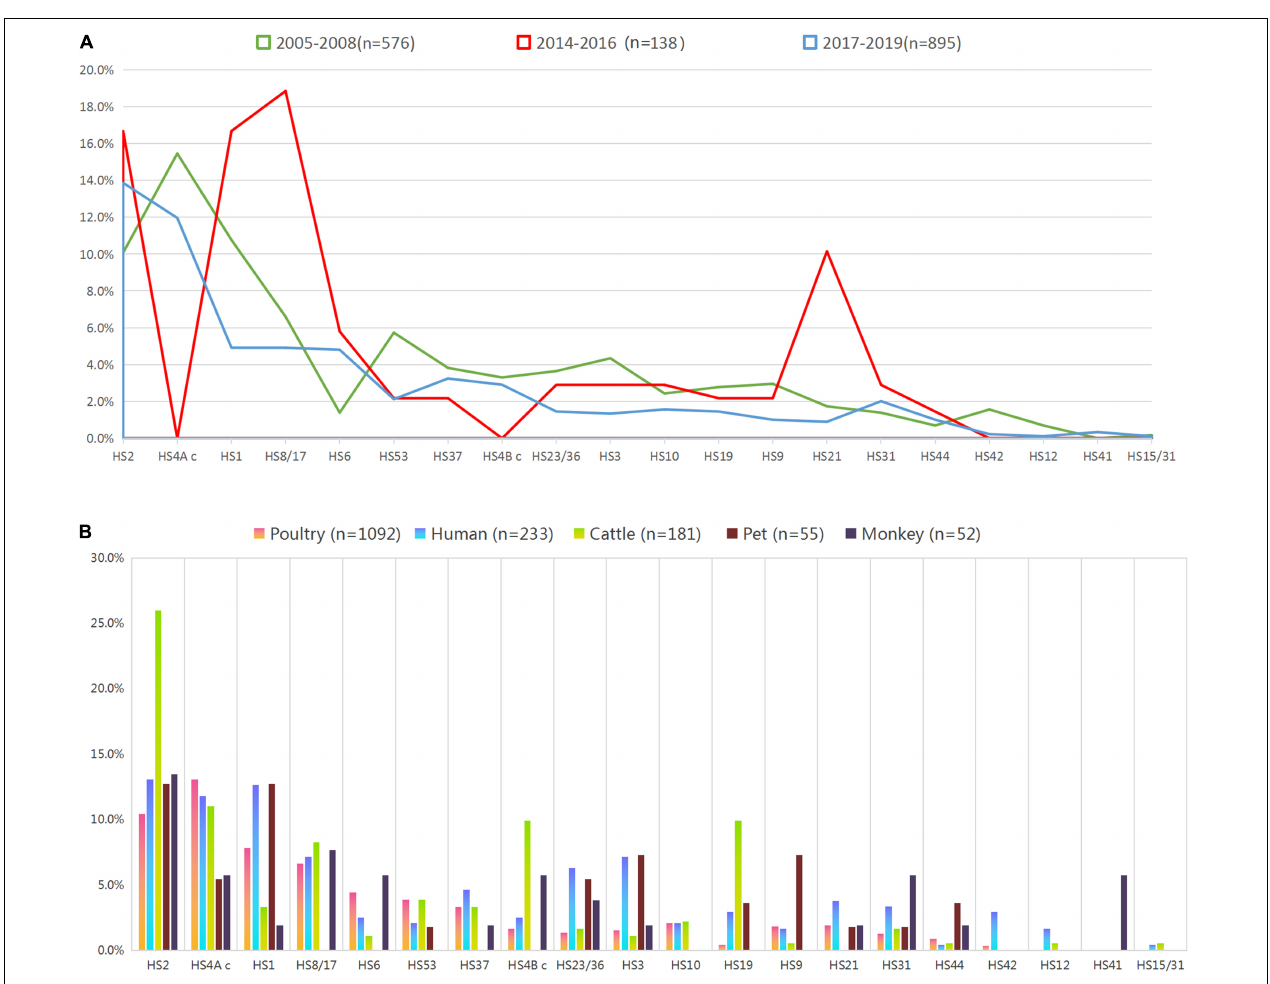
FIGURE 1 | Proportional representation of capsular genotypes among Campylobacter jejuni isolates. (A) Frequency of capsular genotype among isolates from different year intervals. Colors of the lines indicate isolates from different year intervals. (B) Frequency of capsular genotype among isolates from enteritis patient, monkey, pet, cattle, and poultry. Colors of the bars indicate isolates from different